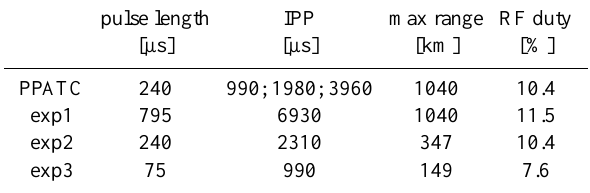
Table 2. The experiments used in the comparisons. The listed ex- periments have approximately the same “beam duty cycle” (12%), the differences in the RF duty are mainly due to the requirement of starting the transmitter 40µs before the actual pulse. All of the experiments use the same bit length (15µs) in phase-coding. An optimised code sequence is used in the PPATC experiment and a strong type 1 alternating code in the other experiments. exp1 has the same range coverage, exp2 the same pulse length and exp3 the same pulse-to-pulse lag resolution as the PPATC